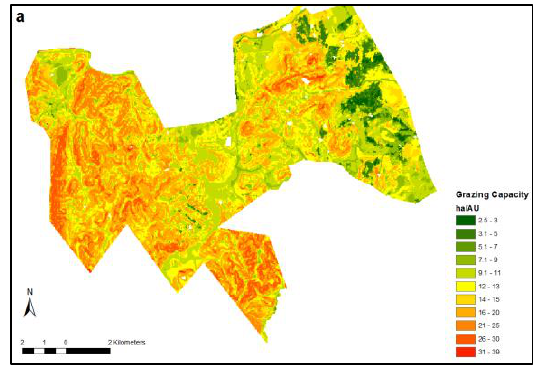
Figure 6. (a) Modelled graze capacity